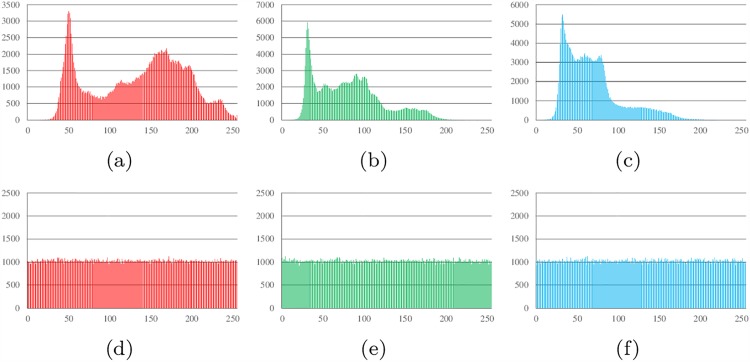
Histogram analysis results of Lena.(a) Histogram of red channel of Lena; (b) Histogram of green channel of Lena; (c) Histogram of blue channel of Lena; (d) Histogram of red channel of cipher; (e)Histogram of green channel of cipher (f)Histogram of blue channel of cipher.